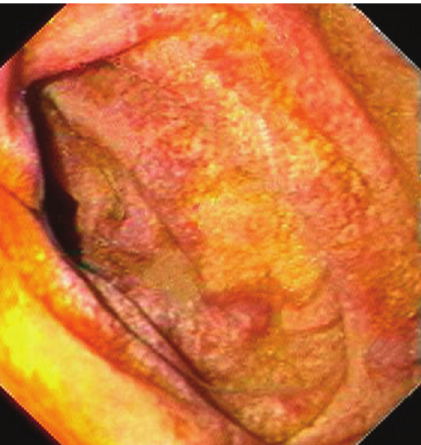
Figure 1: Whipple’s disease: severe involvement of the distal duode- num (D4). Folds are low, and mucosa is swollen and grey-yellowish with multiple reddish spots (small mucosal